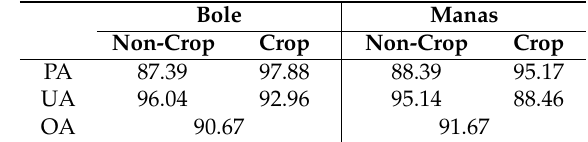
Figure 6. The relationship between the TM/HJ–CCD (NDVI calculated from the TM/HJ images) and the MODIS NDVI (NDVI calculated from the MODIS images) during the growing season for crops in Manas County during 2011 ( n = 345). DOY, day of year; n, the number of samples used for the transformation. Table 6. Confusion-matrix of the classification process of “crop” and “non-crop” (%). Bole